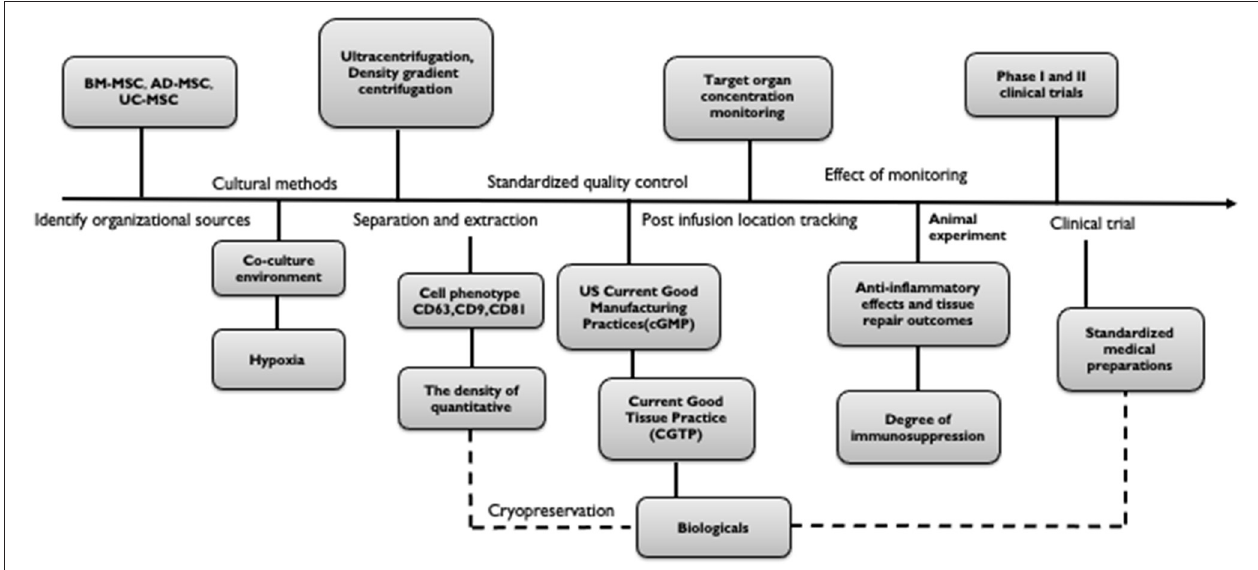
FIGURE 2 | Standardization process for the preparation of exosomes for medical biologics. The process is as follows: (a) Identify organizational sources (BM-MSC, AD-MSC, UC-MSC, etc.). (b) Culture and separation (condition, environment, segregation pattern). (c) Test confirmation (cell phenotype, quantity, purity). (d) Standardized quality control (cGMP, CGTP). (e) Post-infusion location tracking (target organ concentration monitoring, efficacy monitoring). (f) Clinical trial (Phase I and II).